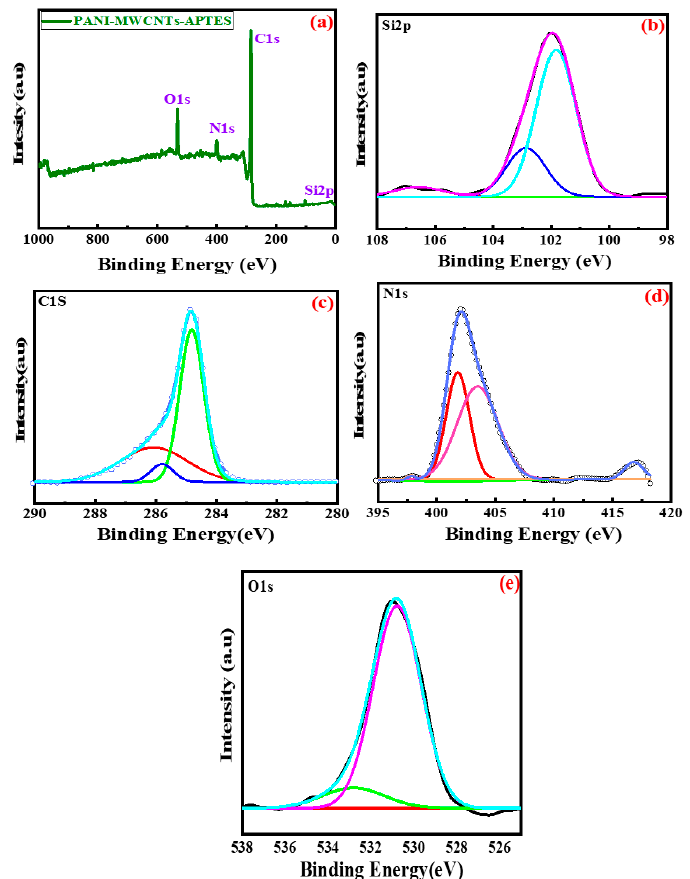
Figure 3. XPS spectrum of PANI-MWCNT-APTES: ( a ) Full spectrum. ( b ) Deconvoluted peak for Si. ( c ) Deconvoluted peak for C. ( d ) Deconvoluted peak for N. ( e ) Deconvoluted peak for O. The peak at around 530 eV is attributable to the oxygen peak. It was deconvoluted into two peaks, 531 eV and 533.2 eV belonging to C-O bond of carboxylic acid in MWCNT and Si-O of triethoxylsilane constituent (Figure 3e). Finally, the peak observed at 100 eV revealed peaks at 102 and 103 eV attributable to Silica. (Si-O) of the triethoxylsilane (Figure 3b) [44]. Nitrogen also exhibits two peaks when deconvoluted, giving rise at 402 eV and 416 eV (Figure 3d). This peak, as indicated earlier, could be linked to N-H strong stretch of PANI and C-N of PANI/MWCNT